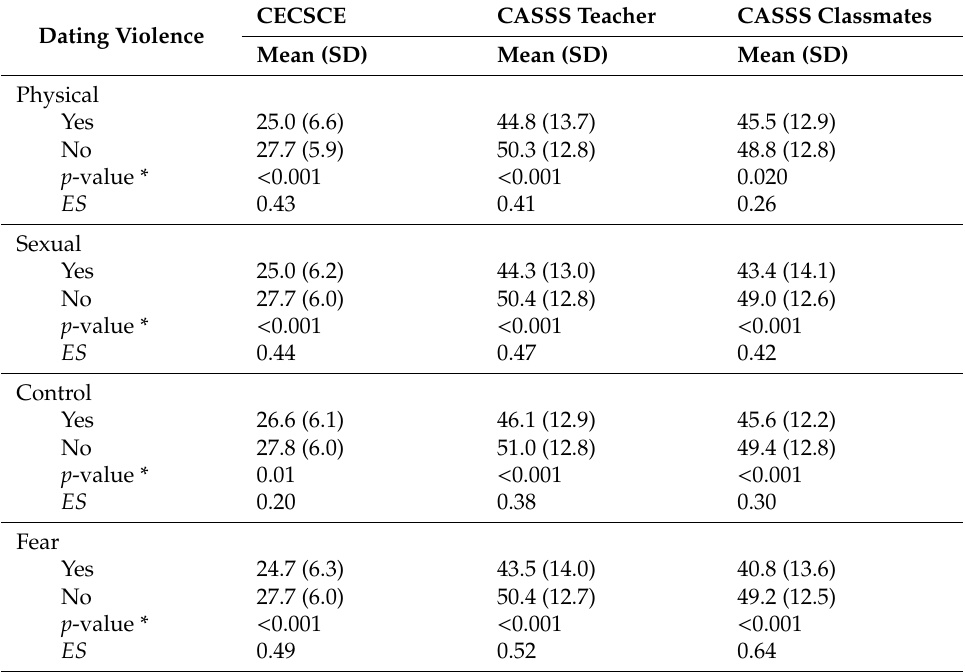
Table 3. Means of social school support and school climate by dating violence